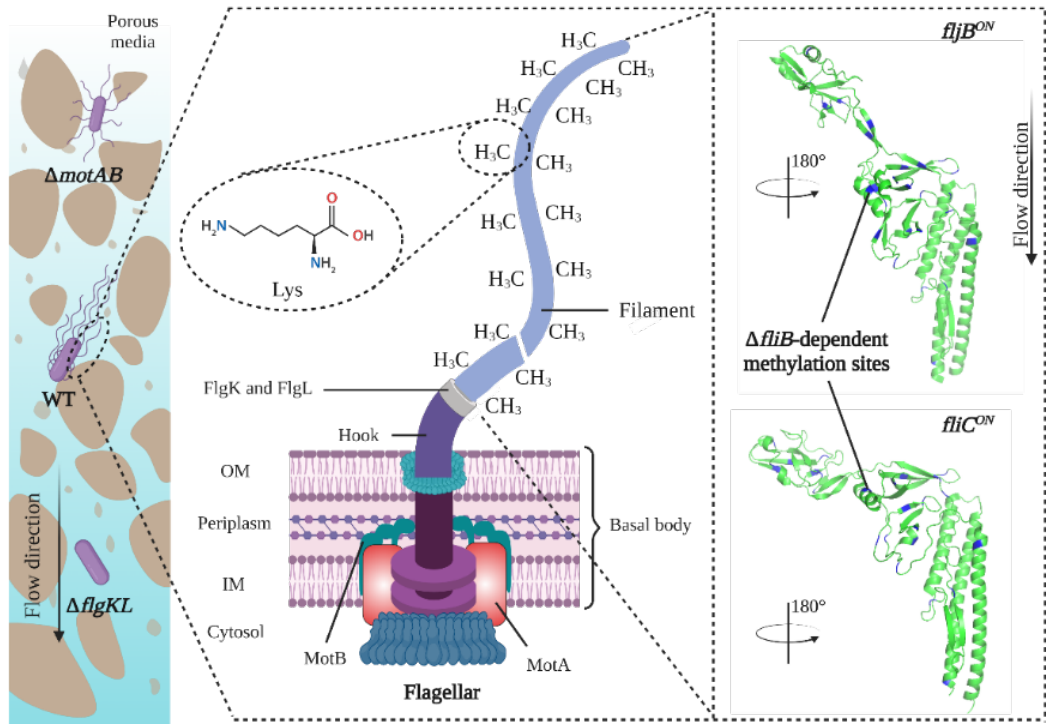
Figure 4. Schematic representation of the structure of bacterial flagellum.